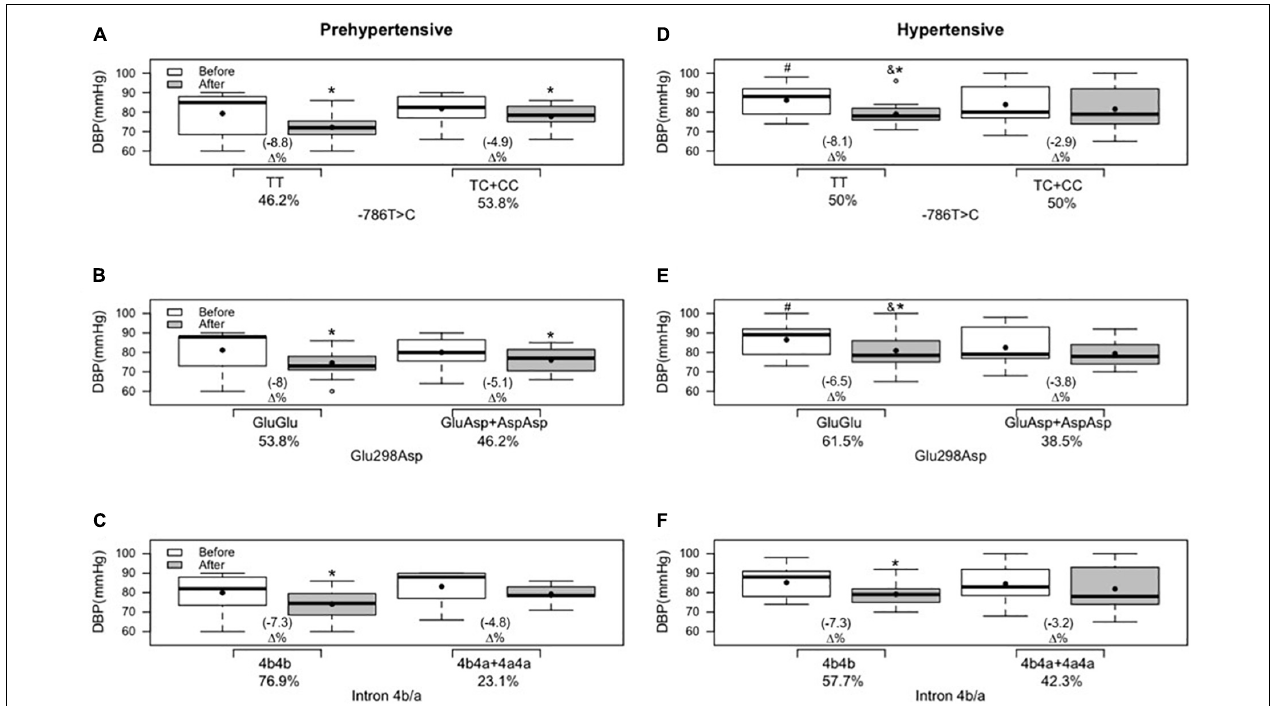
FIGURE 3 | Effects of 12 weeks of multicomponent training on diastolic blood pressure (DBP) of 26 prehypertensive and 26 hypertensive older adult women with or without variant genotypes for the NOS3 gene at positions –786T > C, 894G > T (Glu298Asp), and intron 4b/a. * p < 0.05 compared with before the intervention (the same group). # p < 0.05 ancestral genotype of the hypertensive group compared with the ancestral genotype of the prehypertensive group (“TT” versus “TT”; “GluGlu” versus “GluGlu”) before the intervention. & p < 0.05 ancestral genotype of the hypertensive group compared with the ancestral genotype of the prehypertensive group (“TT“ versus “TT”; “GluGlu” versus “GluGlu”) after the intervention. (A) Genotypes for the NOS3 gene at position − 786T > C in the prehypertensive group. (B) Genotypes for the NOS3 gene at position 894G > T (Glu298Asp) in the prehypertensive group. (C) genotypes for the NOS3 gene at intron 4b/a in the prehypertensive group. (D) Genotypes for the NOS3 gene at position − 786T > C in the hypertensive group. (E) Genotypes for the NOS3 gene at position 894G > T (Glu298Asp) in the hypertensive group. (F) Genotypes for the NOS3 gene at intron 4b/a in the hypertensive group. Linear mixed-effects